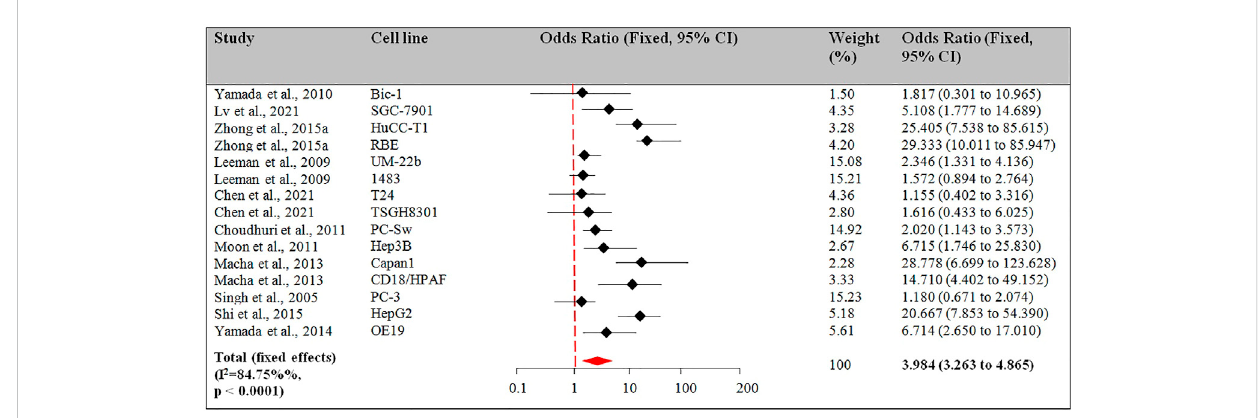
FIGURE 4 Guggulsterone(t = 24 h) versus control odds ratio incancer cells. Fixed effects meta-analysis was performed for the outcomesto comparedata for Guggulsterone (t = 24 h) versus control and the odds ratio was determined.